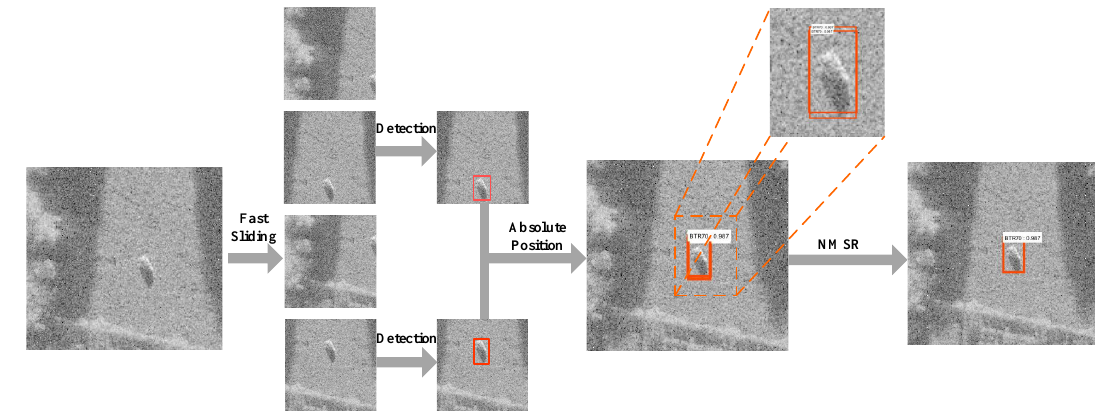
Figure 6. Non-maximum suppression between